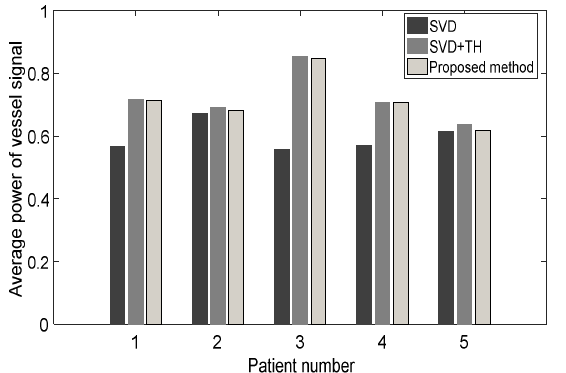
Figure 8. Average vessel power signal for microvasculature images of five breast lesions, comparing SDV, SVD+TH, and the proposed method (NLM+TH).